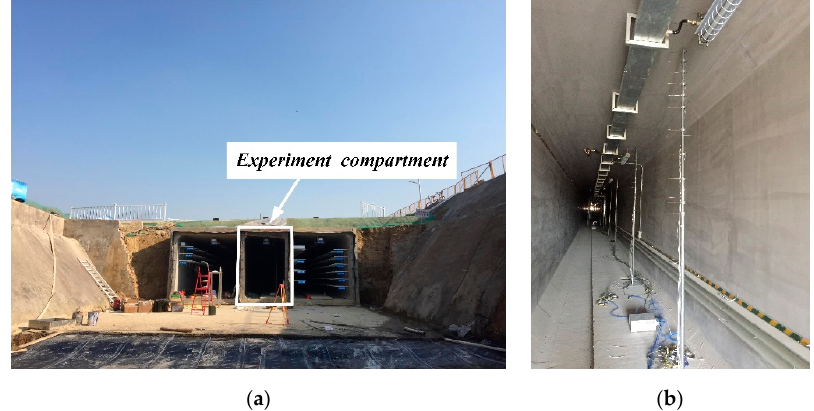
Figure 4. Photos of the experiment compartment in a utility tunnel under construction: ( a ) the full-scale utility tunnel; ( b ) the compartment cross section.